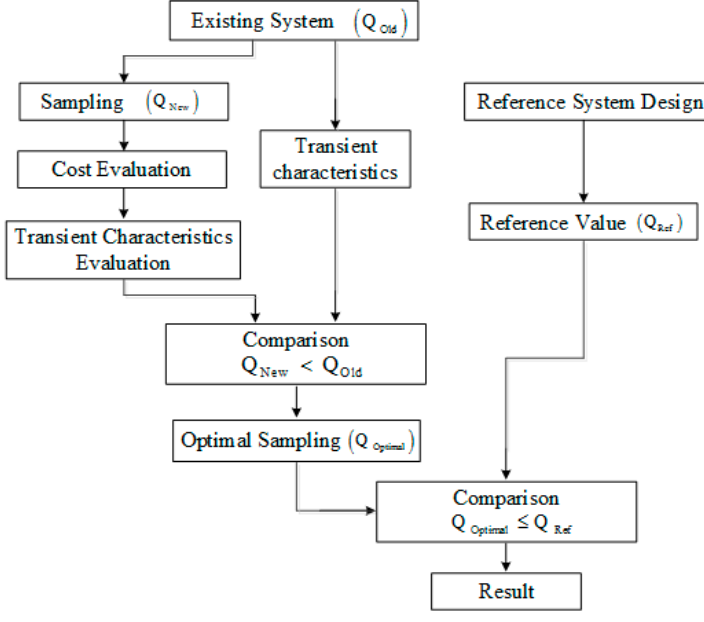
Figure 10. FL algorithm for series compensated transmission lines.